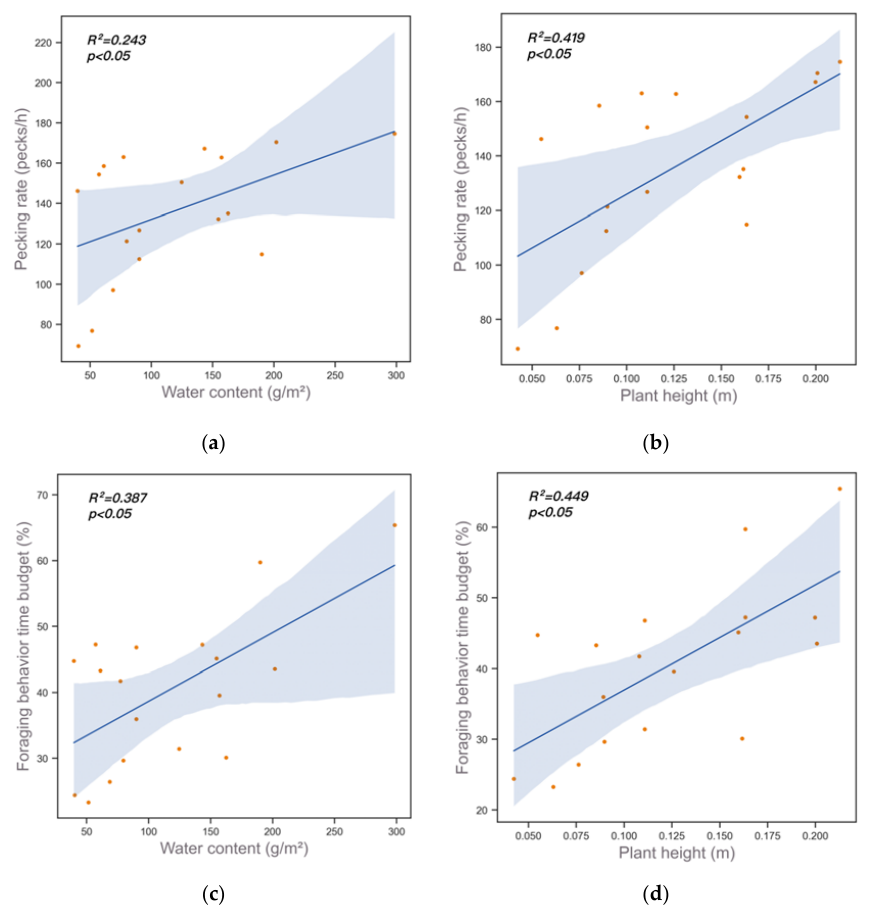
Figure 4. Results of Linear Regression Tests on plant conditions and foraging behavior. ( a ) Water content and pecking rate; ( b ) plant height and pecking rate; ( c ) water content and foraging behavior time budget; ( d ) plant height and foraging behavior time budget. Table 1. Pearson correlation test results between plant characteristics and foraging behaviors.